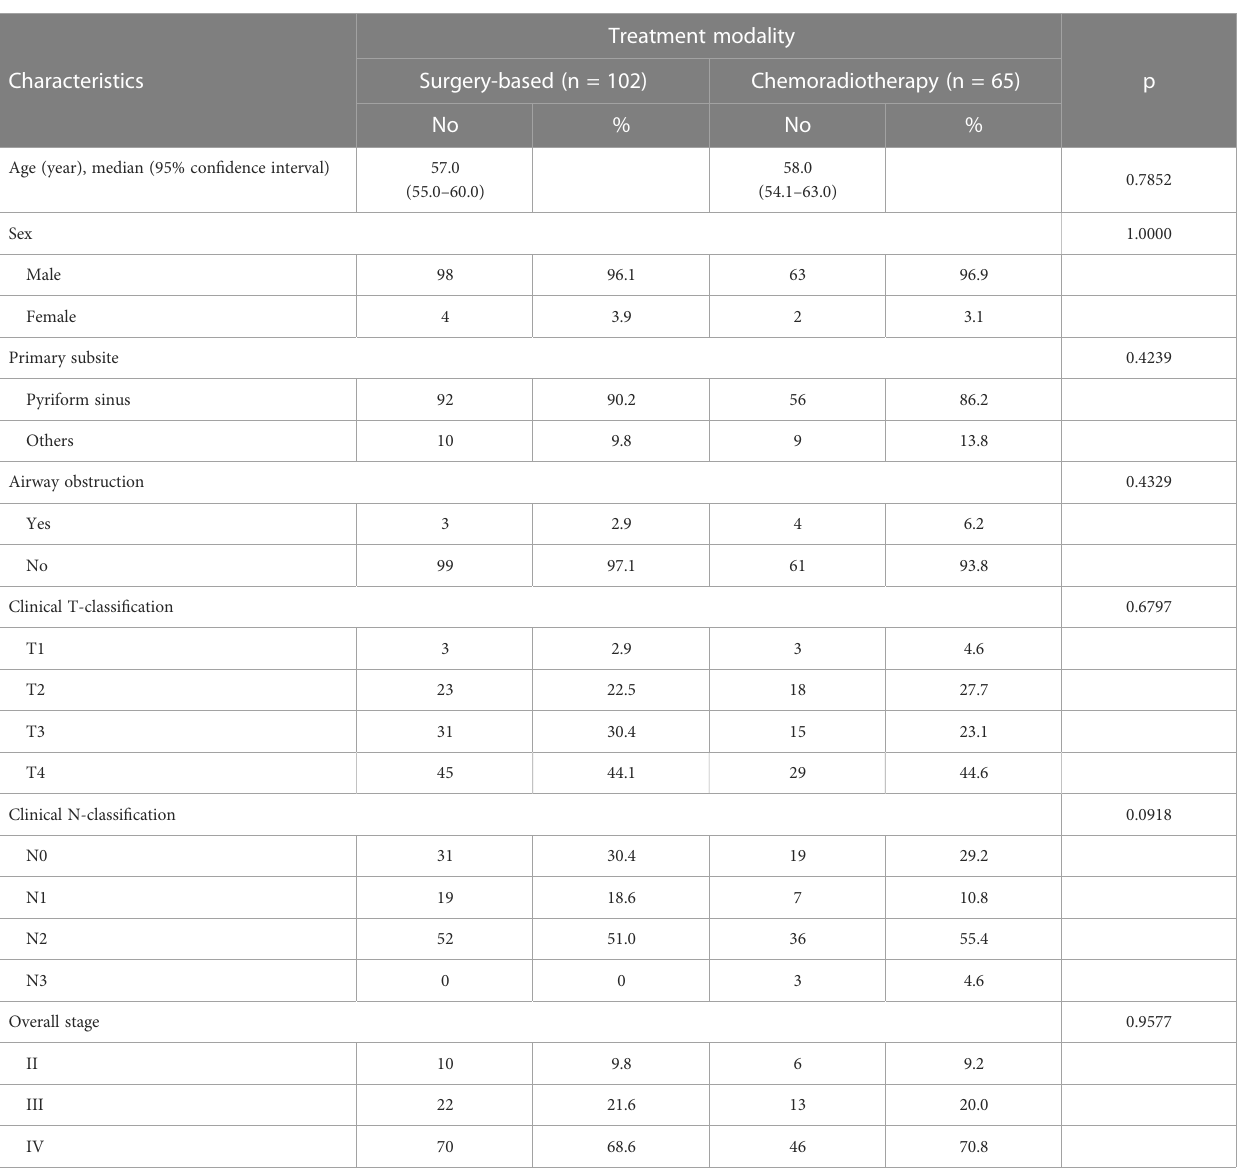
TABLE 1 Patient characteristics.